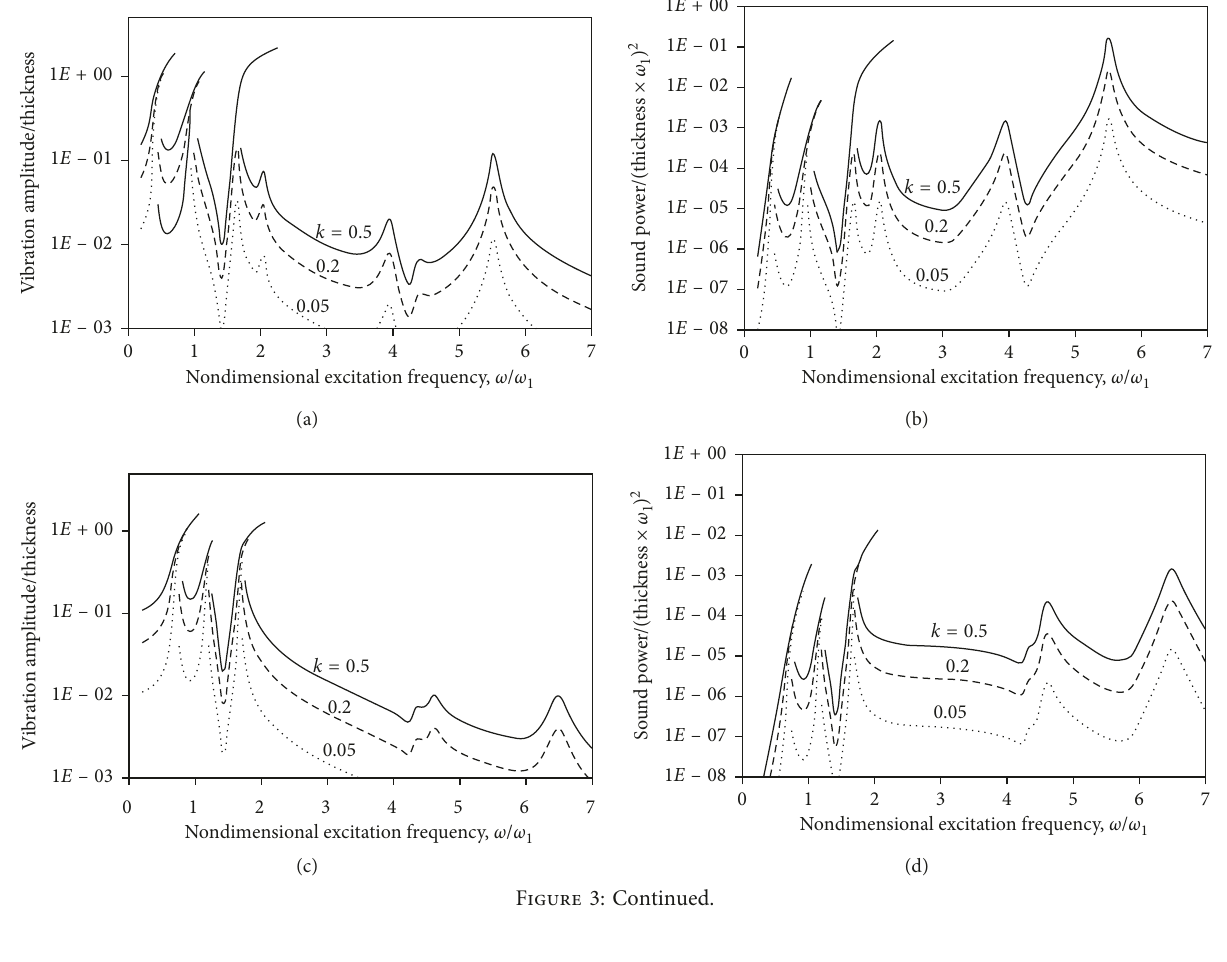
0.5, a 3m, b c 0.5m, ξ 0.02, and N (cid:31) (cid:31) (cid:31) (cid:31) (cid:31) (cid:31)